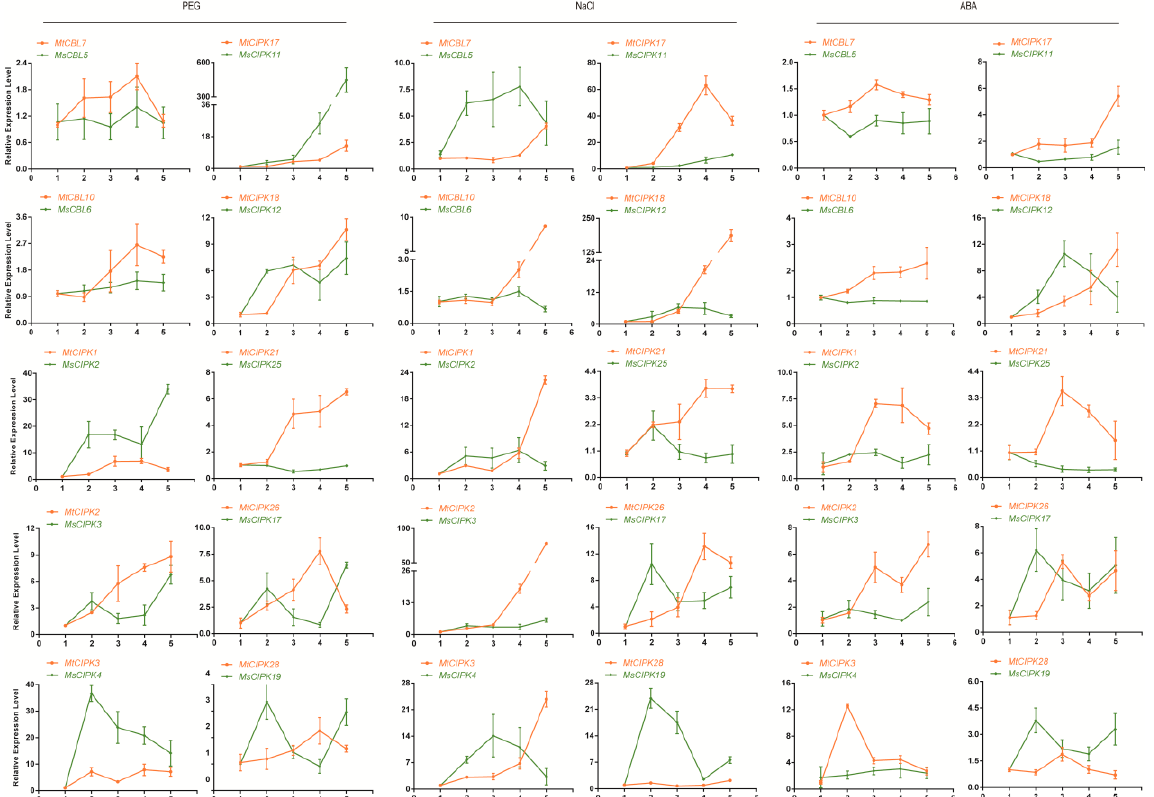
Figure 6. Quantification of gene expression levels of selected CBL and CIPK genes from M. sativa and M. truncatula under PEG, NaCl, and ABA stress using qPCR. Data are average of three independent biological samples ±SE and vertical bars indicate standard deviation. The value 1–5 of X axis for M. sativa represent treatment period of 0, 4, 6, 8, and 24 h, respectively. The value 1–5 of X -axis for M. truncatula represent treatment period of 0, 2, 24, 48, 72 h, respectively.